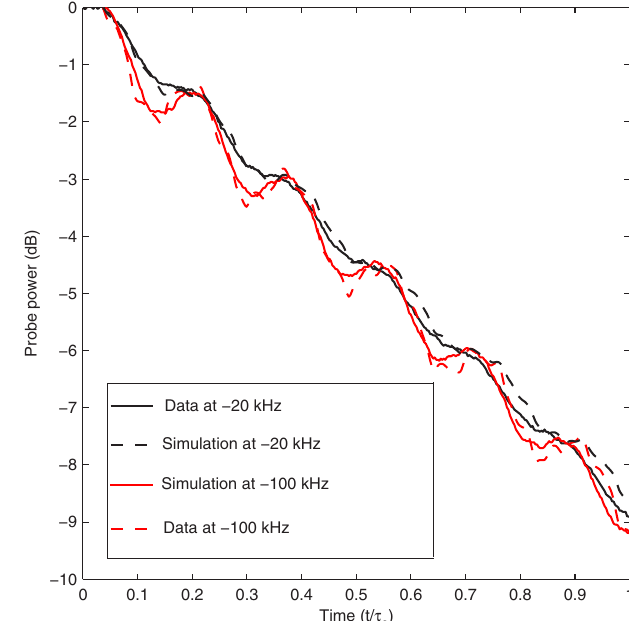
FIG. 3. (Color) Cold test measurements of the cavity reflection (S11) near the (cid:4) -mode frequency and predictions from Eqs. (4) and (5).